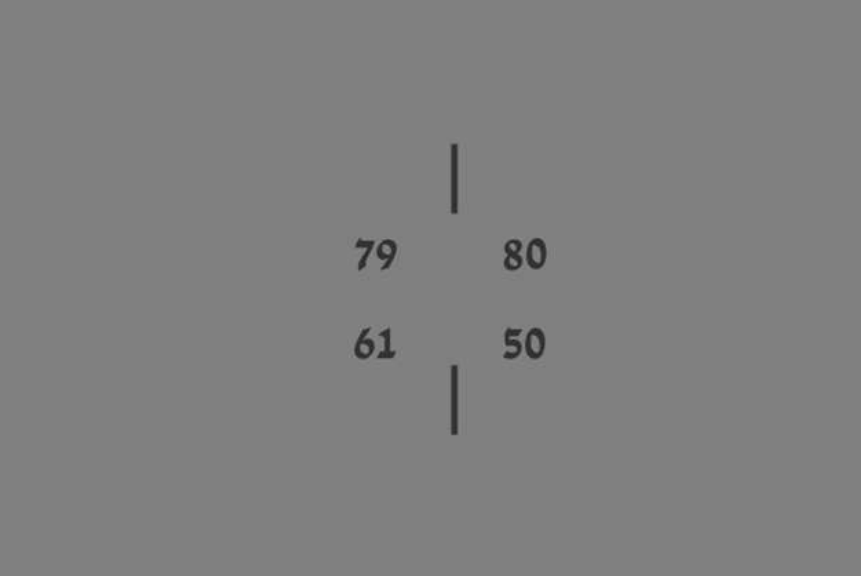
Figure 2. Resource allocation application screen.